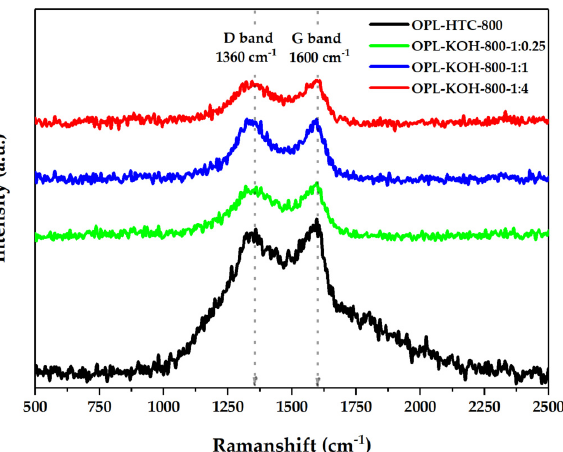
Figure 8. Raman spectra of OPL − HTC − 800, OPL − KOH − 800 − 1:0.25, OPL − KOH − 800 − 1:1, and OPL − KOH − 800 − 1:4. Table 4. Raman spectra of OPL via hydrothermal carbonization and KOH activation.